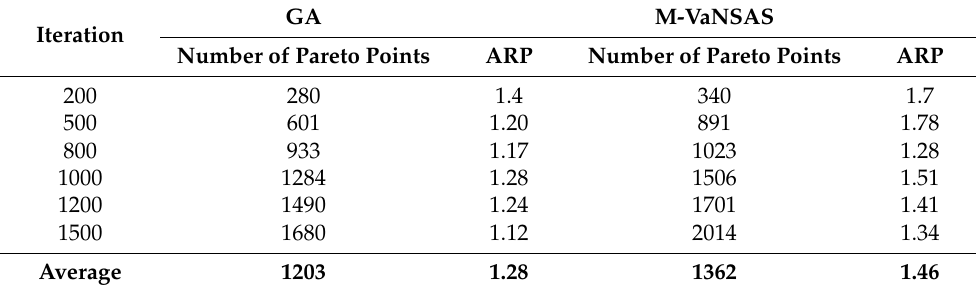
Table 11. Comparison of Pareto ratio of GA and M-VaNSAS. GA M-VaNSAS Iteration Number of Pareto